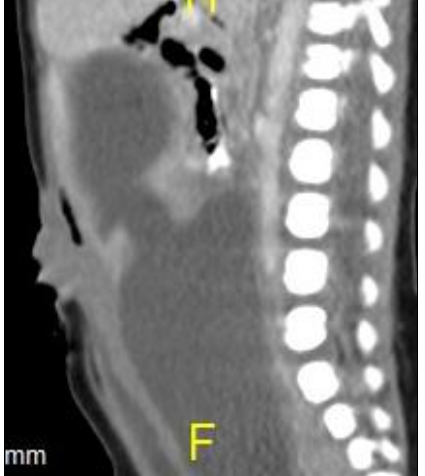
Figure 1: CT-Scan showing hydrometrocolpos. Note the dilated vagina and